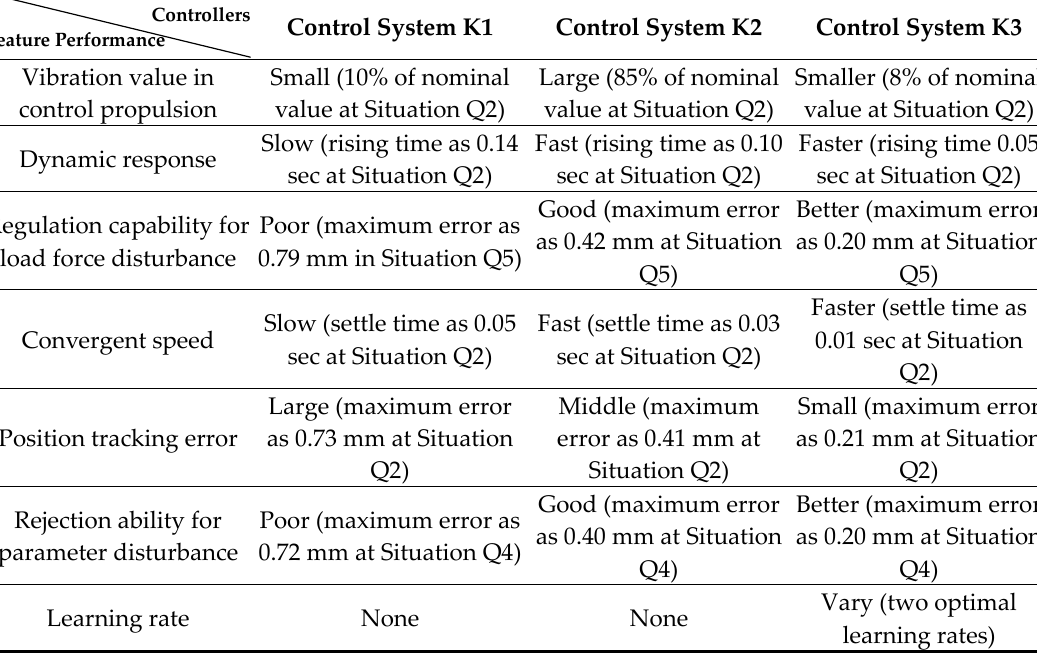
Table 2. Feature performance comparisons of control systems.